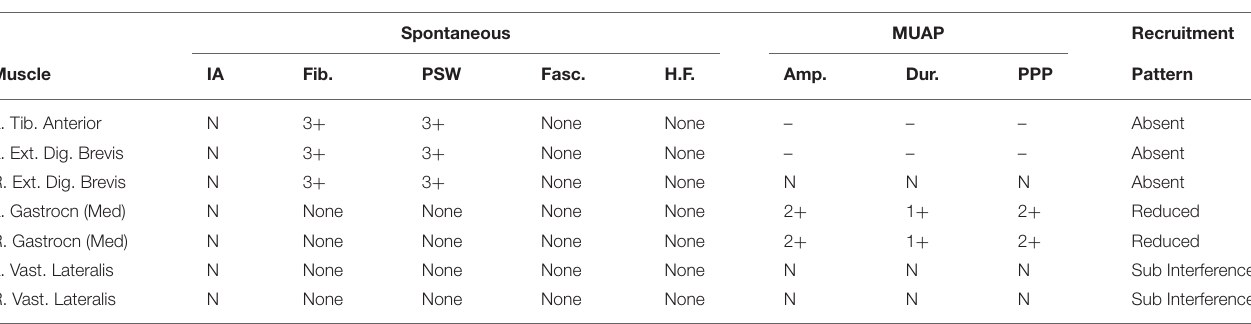
TABLE 1 | Summary table of results of electromyographic examination of May 29. Spontaneous MUAP Recruitment Muscle IA Fib. PSW Fasc. H.F. Amp. Dur. PPP